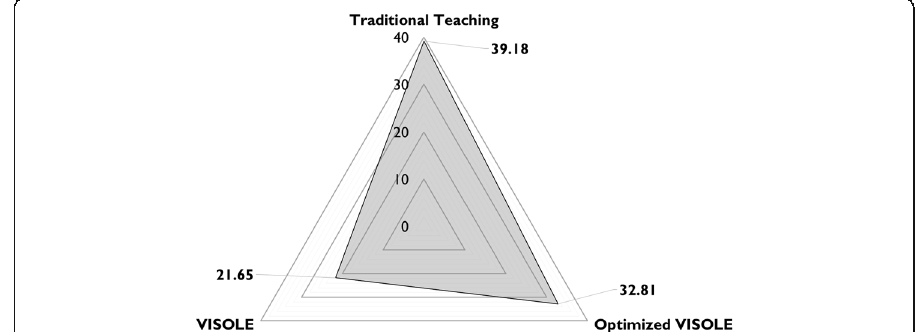
Fig. 2 Overall comparison on knowledge test mean scores obtained at School